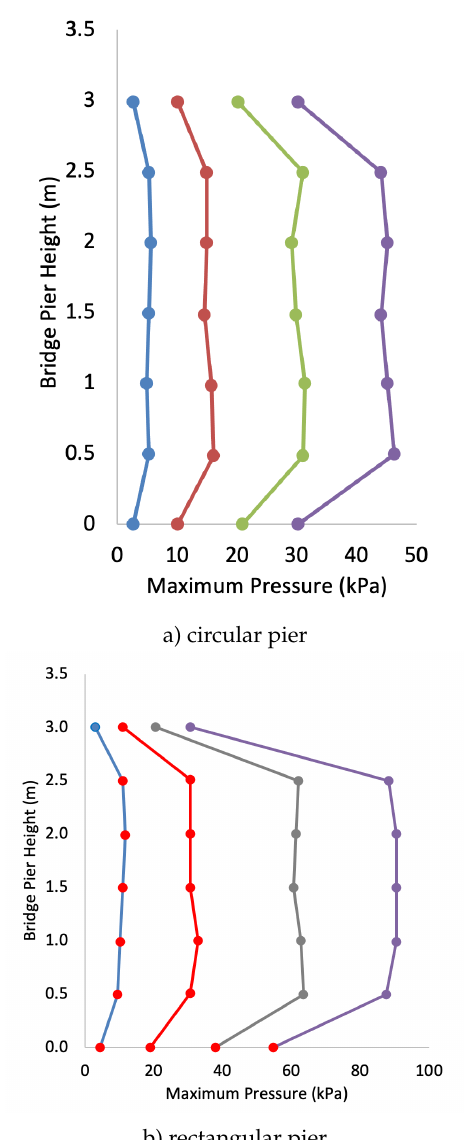
Fig. 7. Fluid pressure distribution along the piers at different velocities.